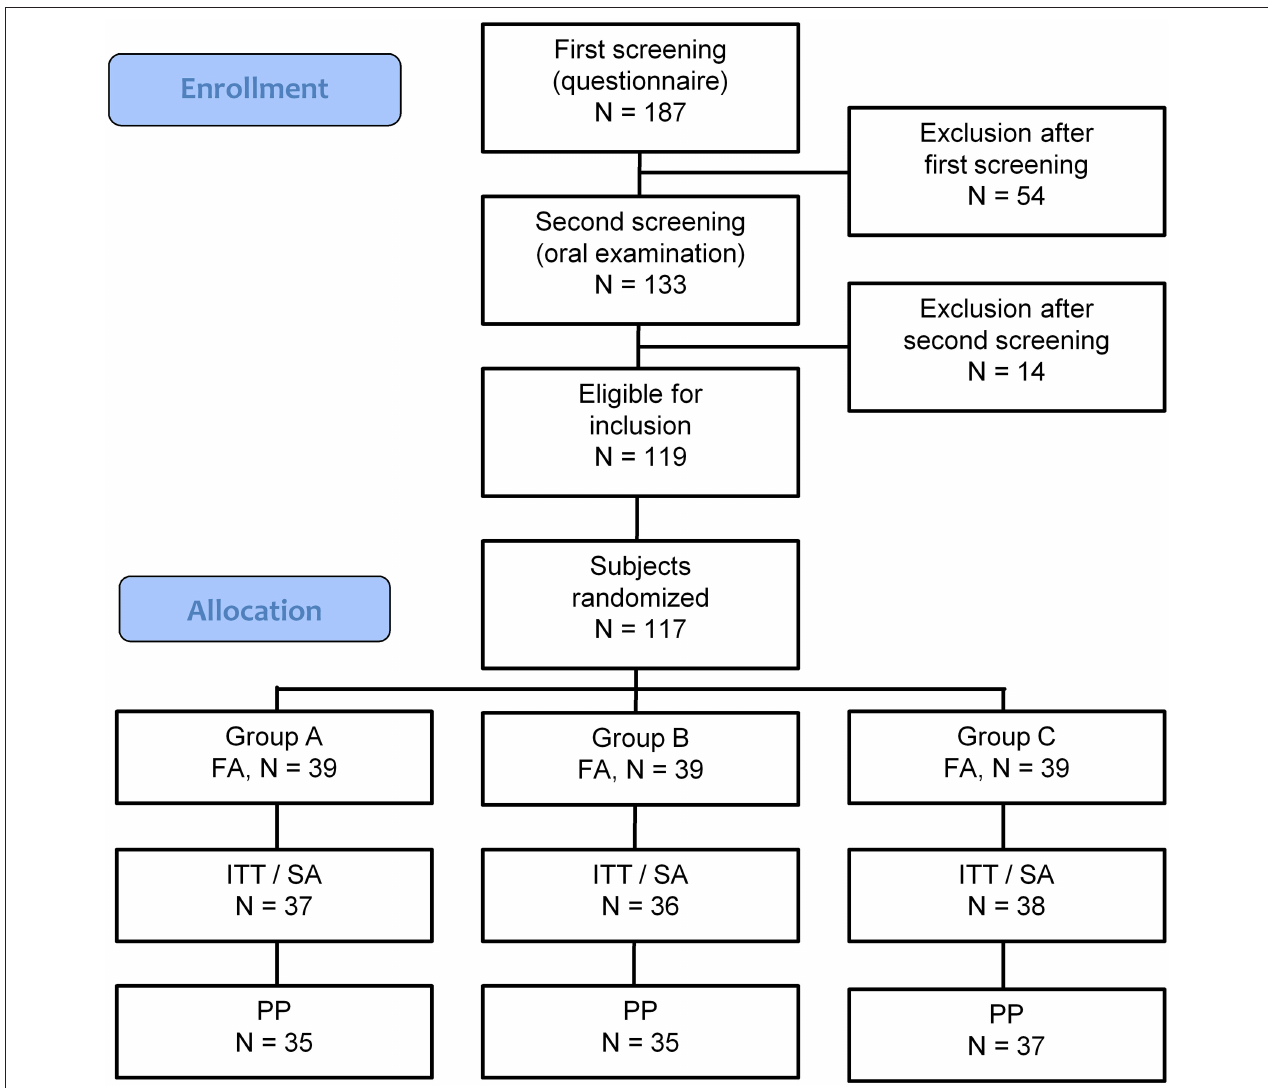
FIGURE 2 | CONSORT-flow chart showing the disposition of subjects. FA, Full Analysis population; ITT, Intention to Treat population; SA, Safety Analysis population; PP, Per Protocol population. Group A: Lactobacillus paracasei LPc-G110 containing lozenges, Group B: placebo lozenges, Group C: Lactobacillus plantarum GOS42 containing